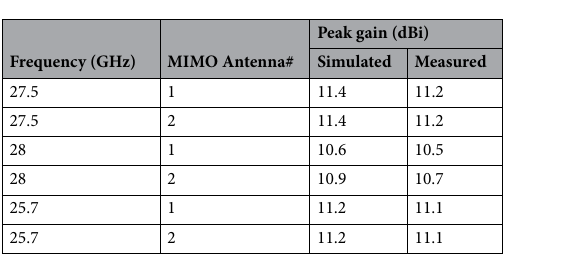
Figure 20. ( a ) Measurement setup ( b , c ) XZ plane (H Plane) radiation pattern of MIMO elements in OFF and ON states of diodes.